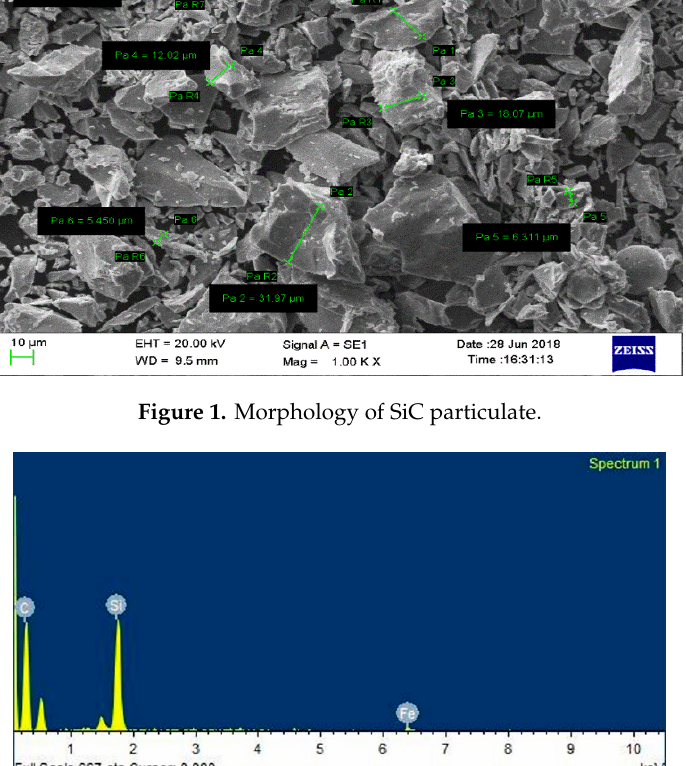
Figure 2. EDAX of SiC particulate.